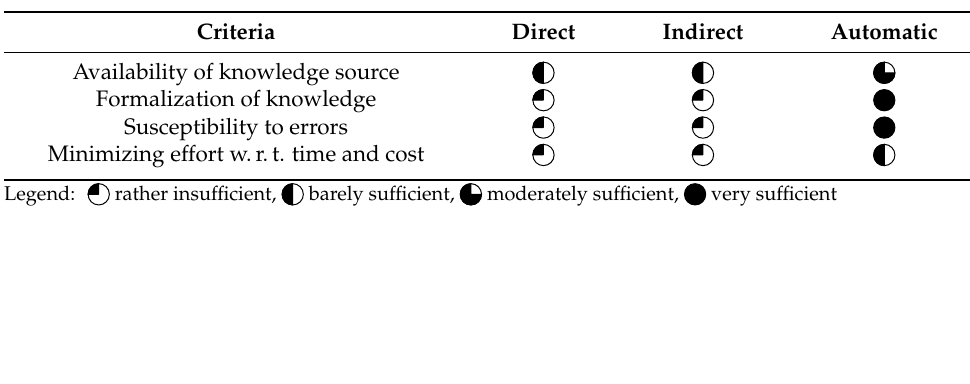
Table 2. Comparison of knowledge acquisition